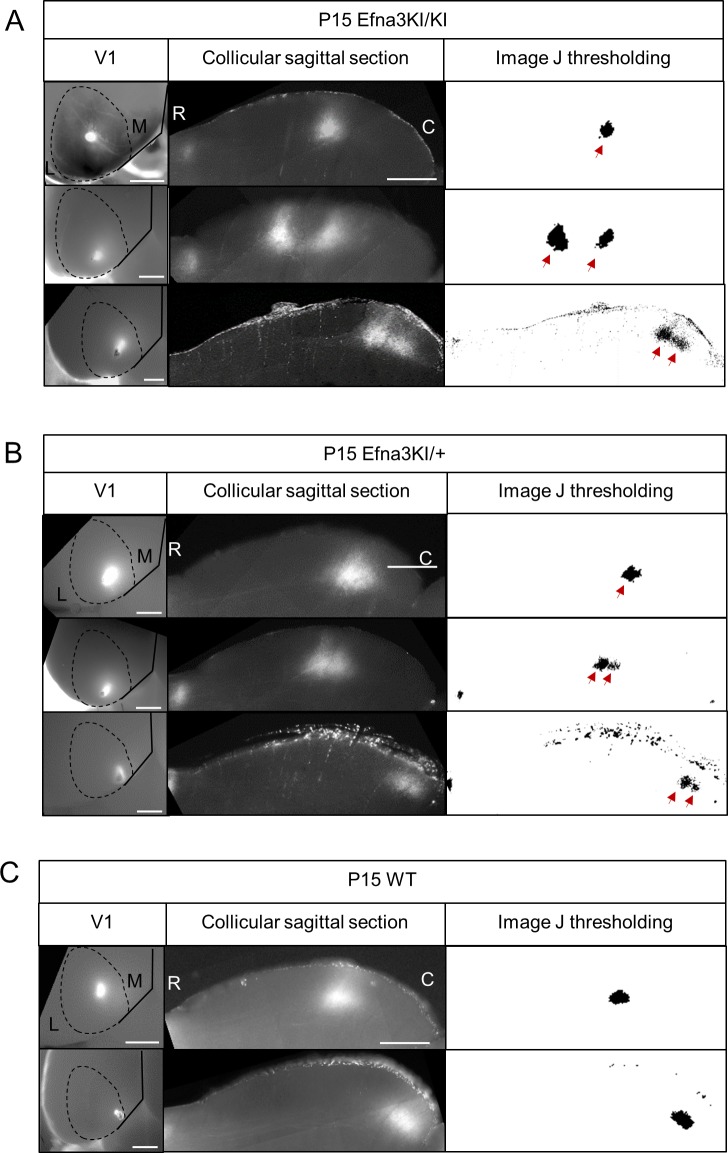
Representative examples of collicular parasagittal sections showing cortical terminations zones and the corresponding injections in V1 in Efna3KI/KI (A), Efna3KI/+ (B) and WT (C) P15 littermates.White panels show the termination zones analyses using ImageJ. Scale bars represent 1 mm (V1 whole-mount), 500 μm (SC), R: rostral, C: caudal, L: lateral, M: medial; WT, wild-type.